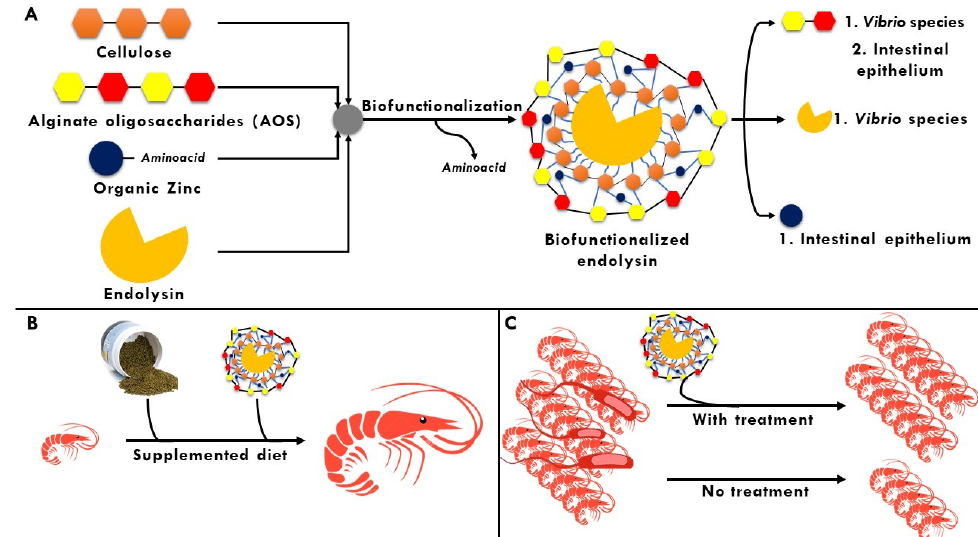
Figure 4. Biofunctionalization as a potential strategy to combat bacteria of interest in aquaculture.